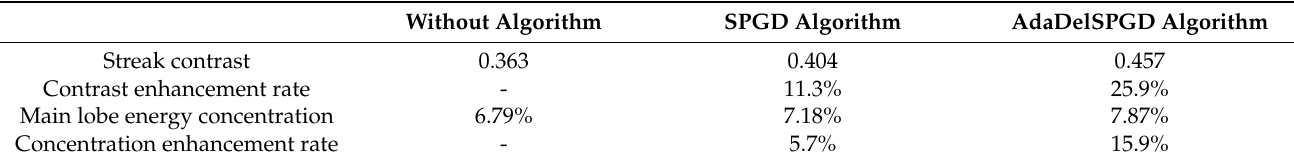
Table 3. The beam quality of interference fringes of different algorithms.